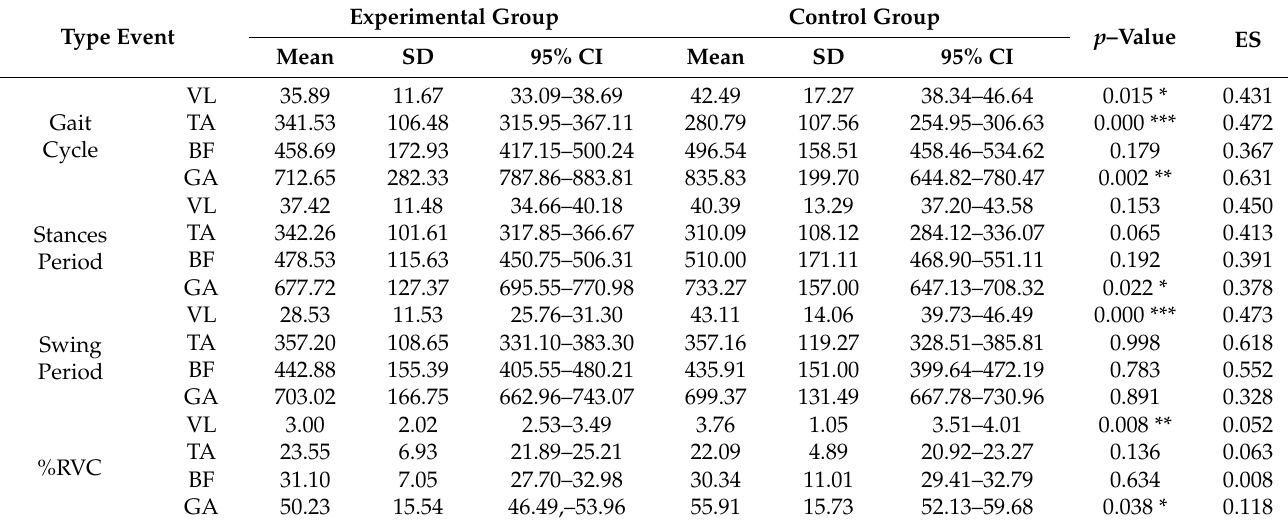
Table 5. Muscle activity in high-heel shoes during walking. (unit: uV,